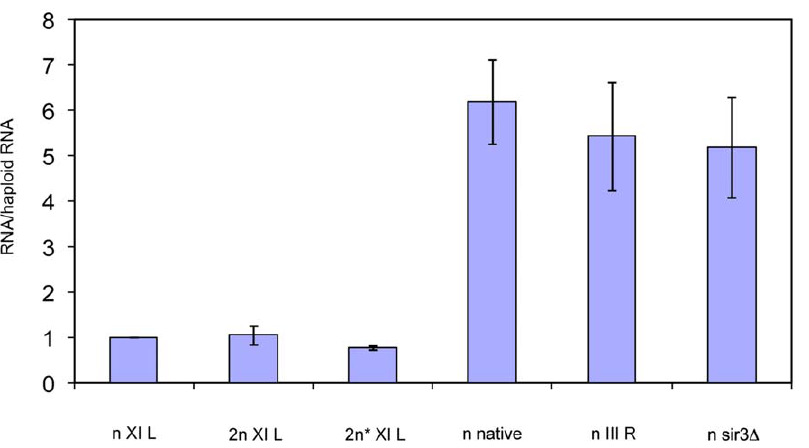
Figure 8. Transcriptional silencing at telomeres does not change with ploidy. mRNA levels were measured by QRT-PCR and compared to the levels in haploid cells. The values plotted are ratios to the amounts in the haploid cells. They are mean values from 3 separate RT-PCR reactions. The error bars show 2 standard deviations. The strains had the reporter positioned at XI-L (n XI L, 2n XI L, 2n* XI L, n sir3 D ), at URA3 native locus (n native), or at III-R (n III R).